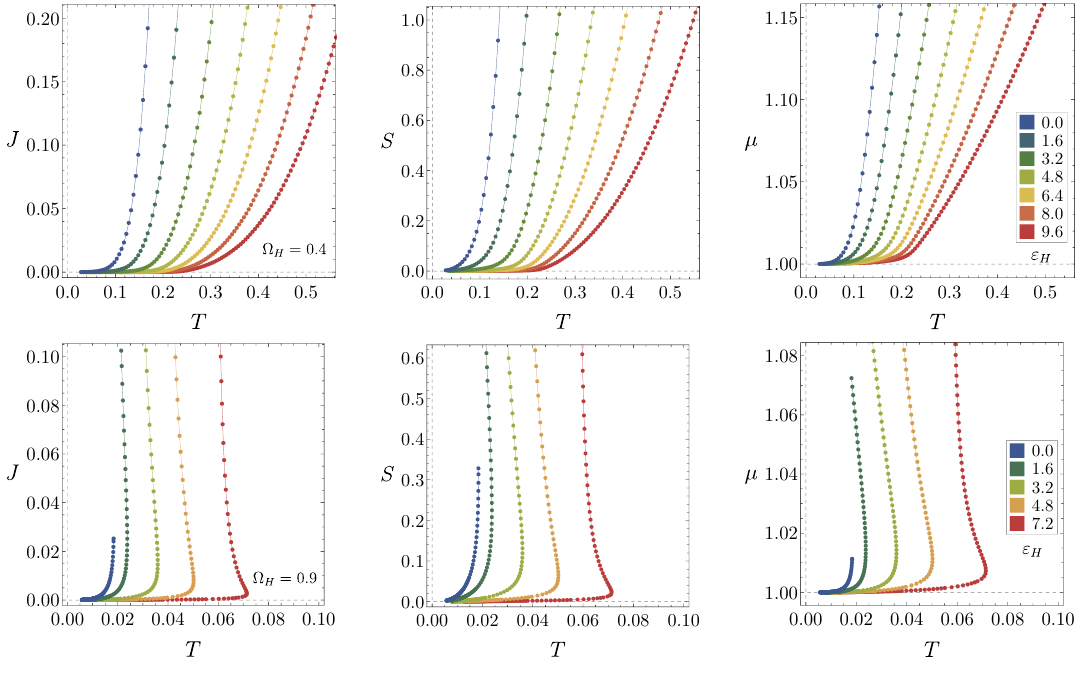
Figure 15 . Thermodynamic quantities for the hairy black hole families with a (cid:12)xed horizon velocity (cid:10) H = 0 : 4 ( top row ) and (cid:10) H = 0 : 9 ( bottom row ), and a constant horizon scalar " H . As the temperature T ! 0, angular momentum J ! 0 ( left ), entropy S ! 0 ( middle ), and chemical potential (cid:22) ! 1 ( right ). For large horizon velocity, there exists a maximum temperature for the hairy black